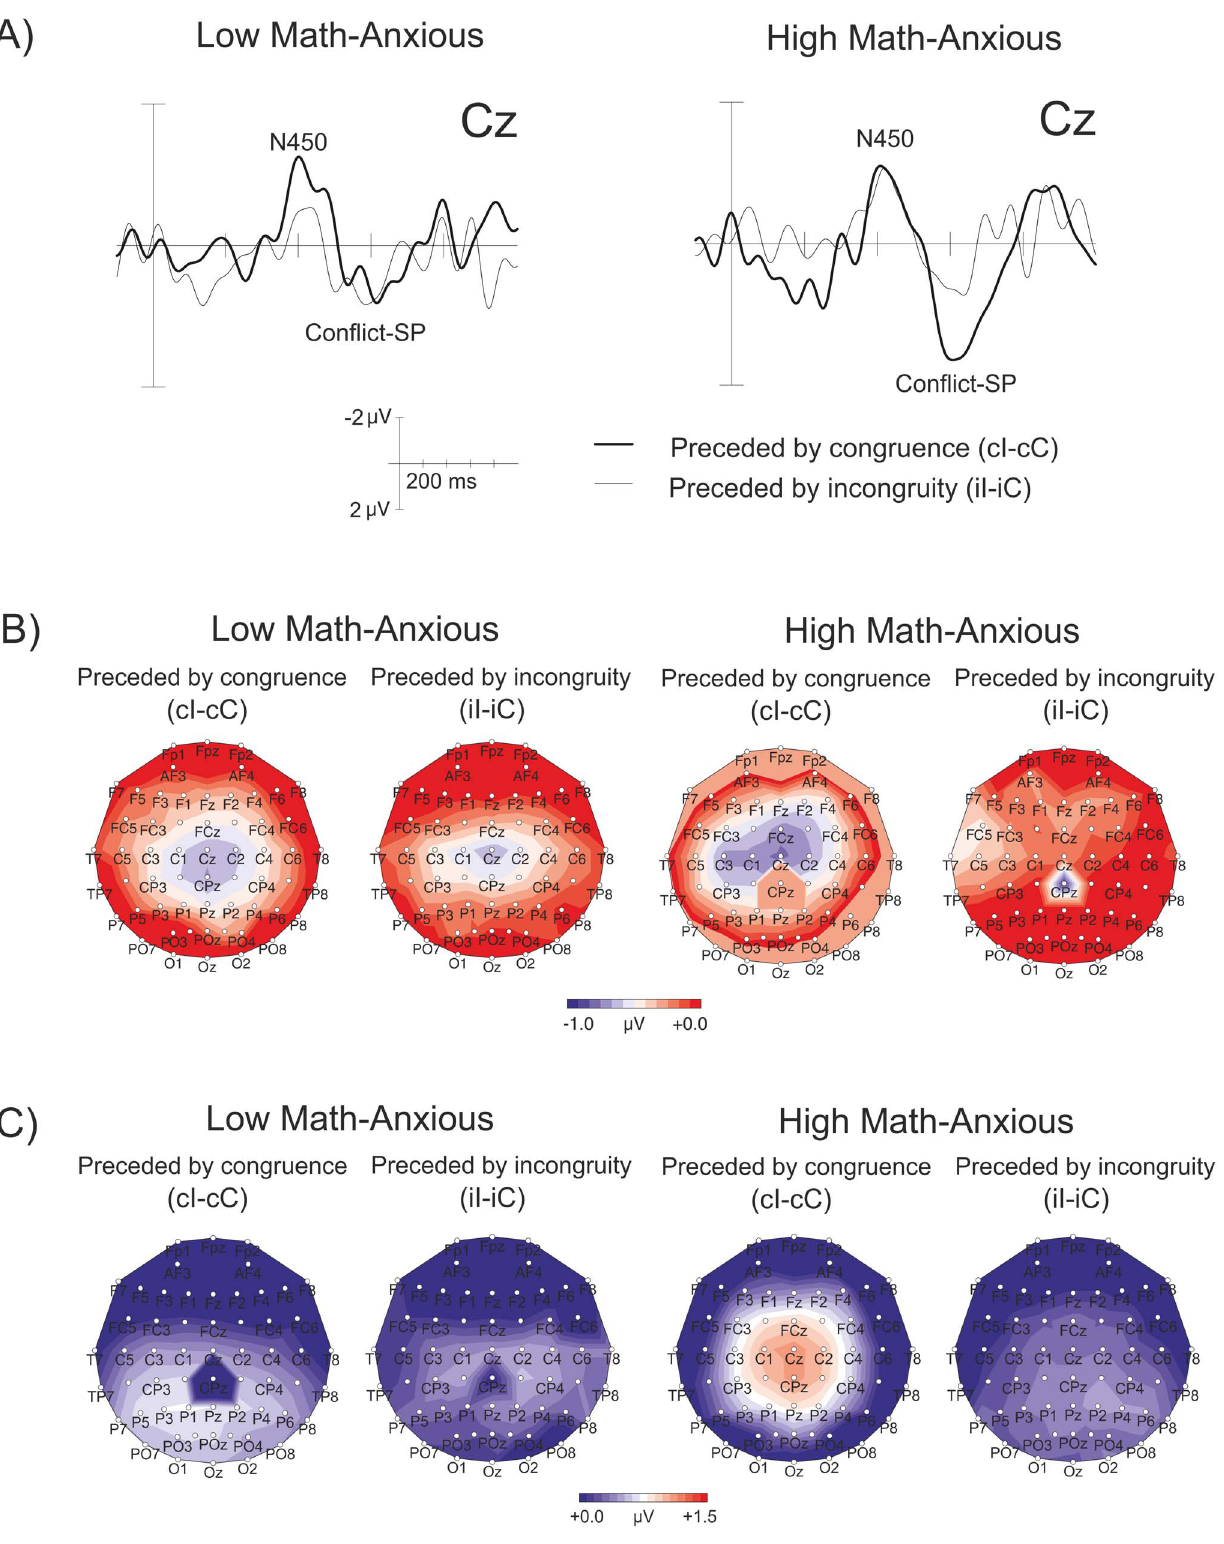
Figure 4. Grand average waveforms at Cz for the N450 component and for the Conflict-SP, showing the interference effect preceded by congruence ( cI-cC ) and by incongruity ( iI-iC ) for the LMA and HMA groups (A) the scalp topography of the N450 component, showing the interference effect preceded by congruence ( cI-cC ) and by incongruity ( iI-iC ) in the 350–500 ms window for the LMA and HMA groups (B) and the scalp topography of Conflict-SP, showing the interference effect preceded by congruence ( cI-cC ) and by incongruity ( iI-iC ) in the 550–750 ms window for the LMA and HMA groups (C).